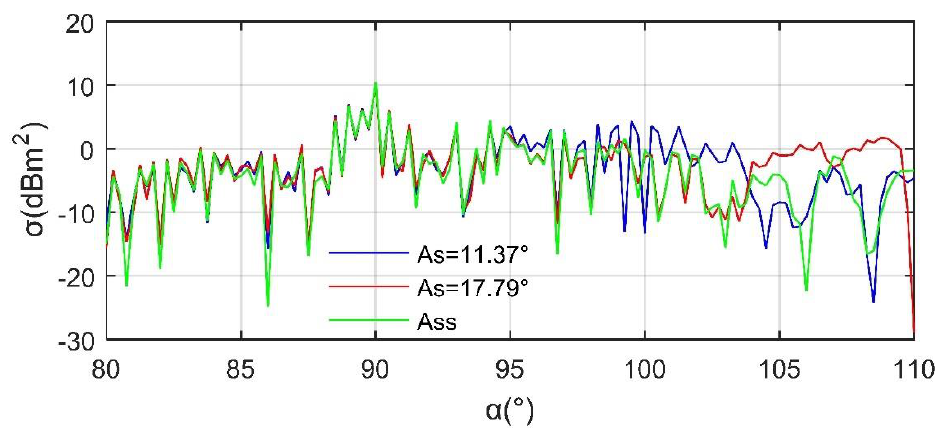
Figure 17. RCS of the aircraft, where α n = 80° , α m = 110°, β = − 10°, and F rh = 5 GHz.